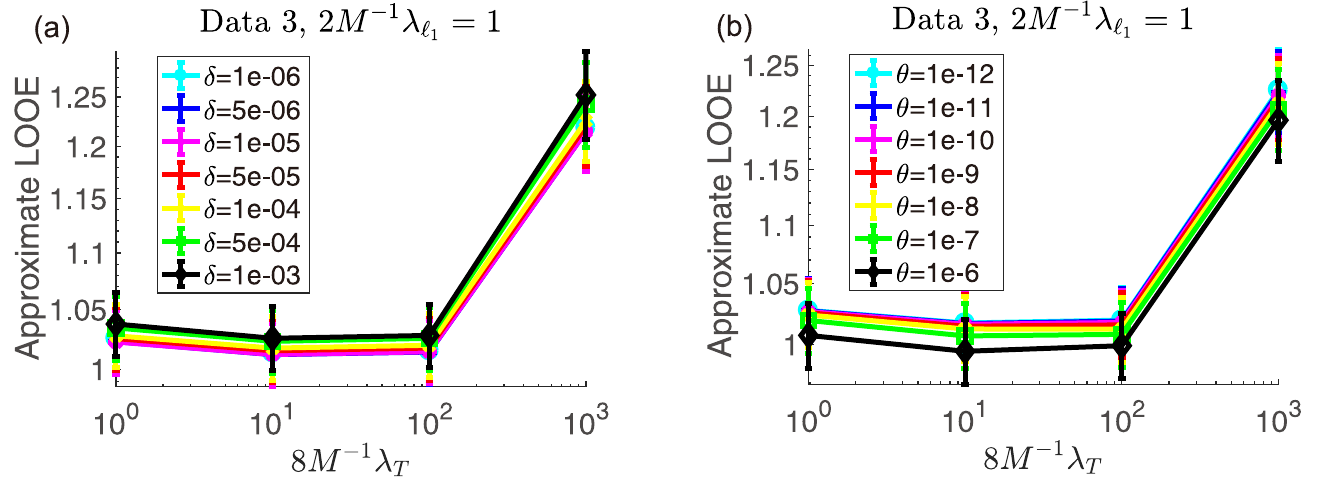
Fig 3. Comparativeplots of mean approximate LOOEs against λ T at 2 M − 1 λ ℓ changes as 10 − 12 –10 − 6 with fixed δ = 10 − 4 . They show that the LOOE curves are rather stable againstthe choice of the tuning constants.